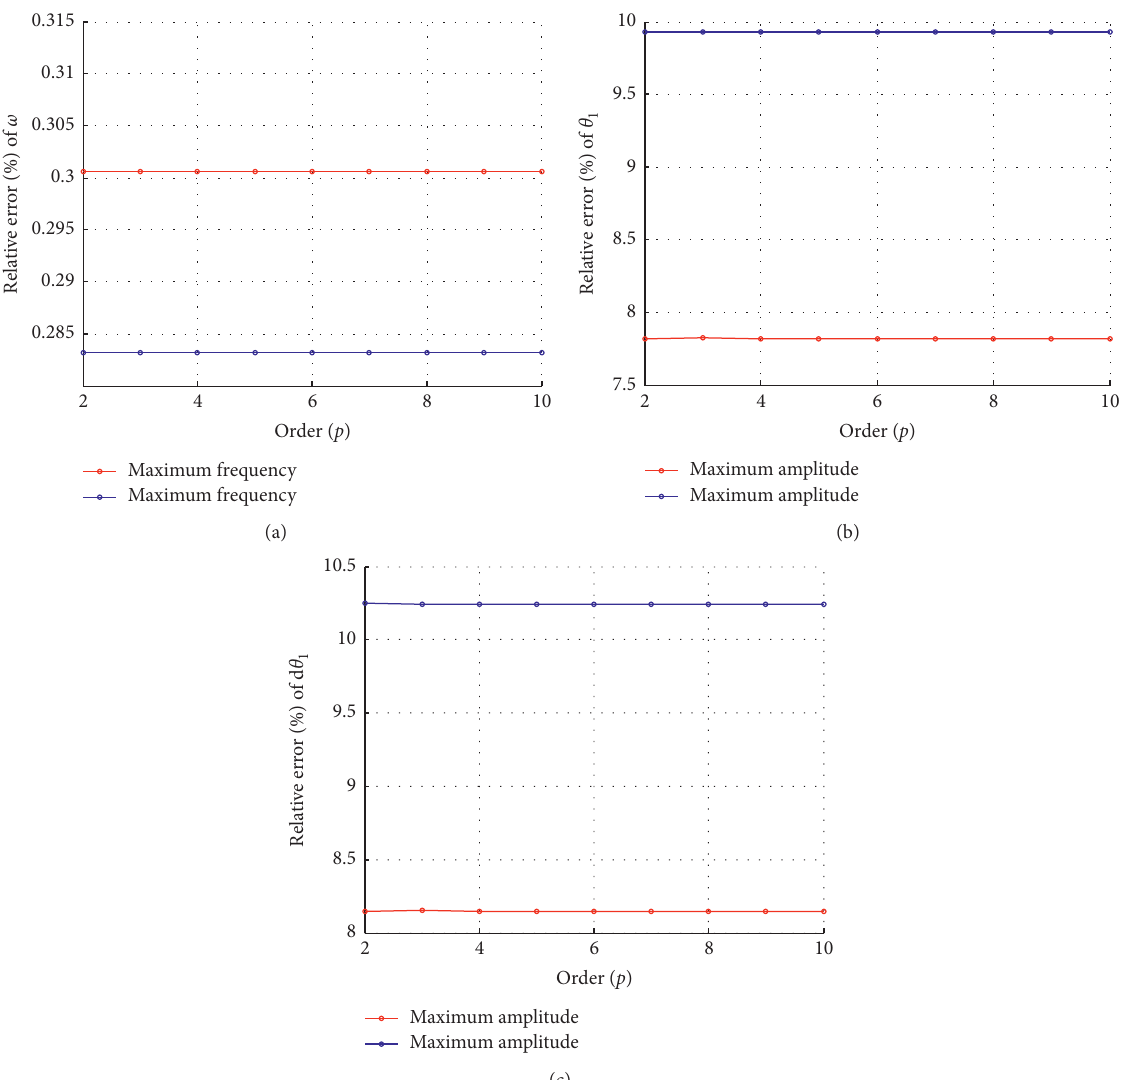
Figure 2: The relative errors (%) of the maximum and minimum frequencies ( ω ) (a) of the maximum and minimum amplitudes of displacements ( θ 1 ) and (b) of velocities (d θ 1 ) (c) between the direct calculation (MC) and ngPC+CHBM with order p .